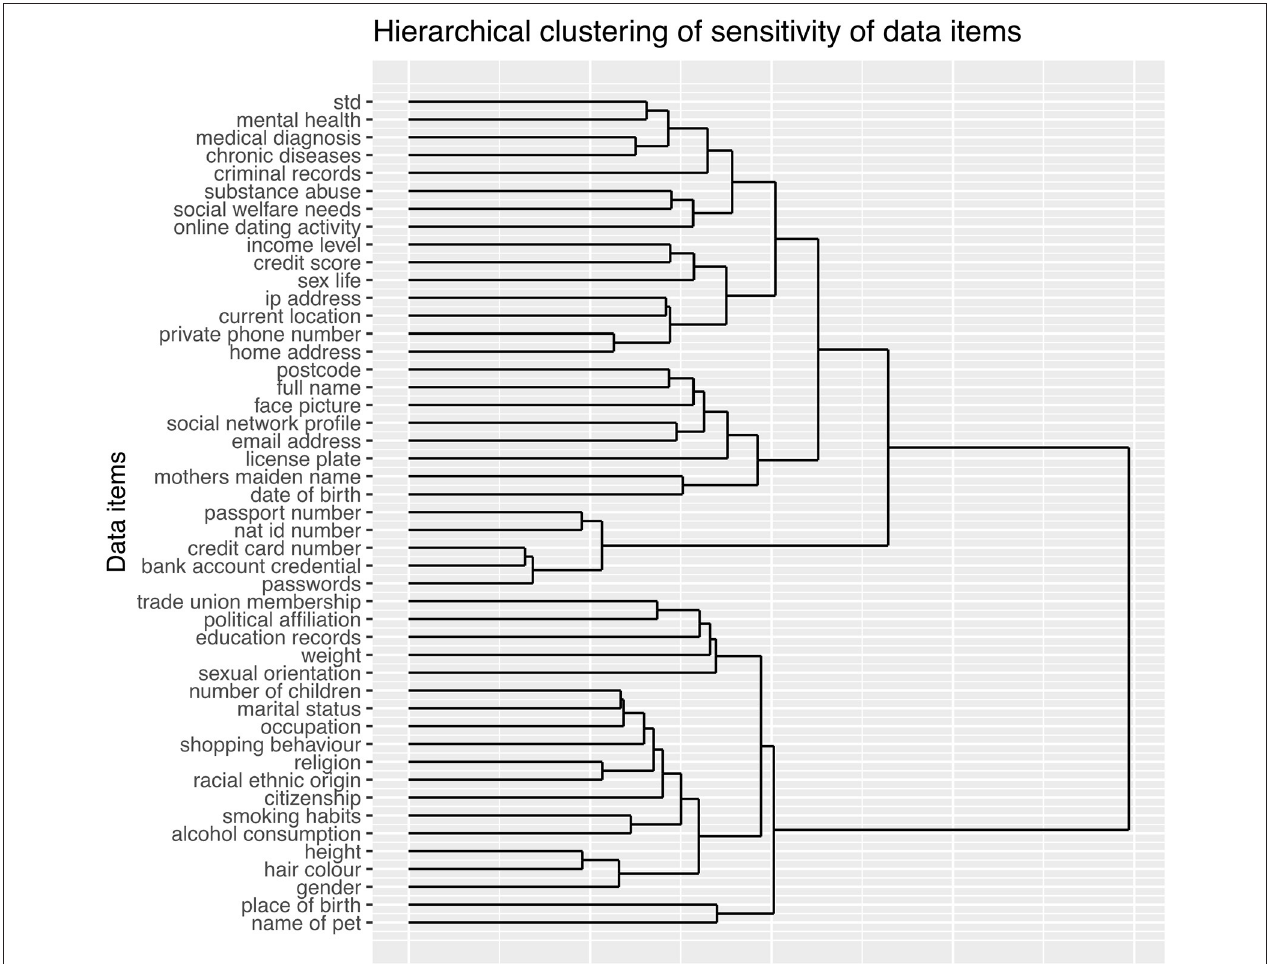
FIGURE 4 | GCSEs are the qualifications taken in years 10 and 11 of secondary school in the UK (typically at the age of 14–16). A-levels are a subject-based qualification offered by the educational bodies in the UK to students completing secondary or pre-university